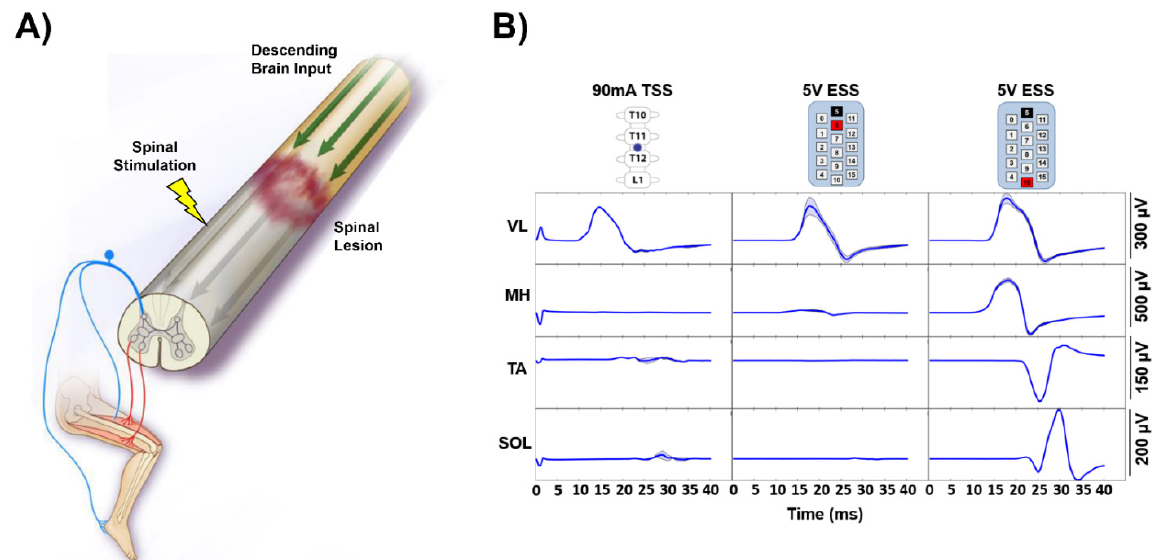
Figure 1. TSS- and ESS-Evoked Responses While Relaxed. A . A diagram depicting inputs and outputs to the spinal cord during spinal stimulation. Descending brain input (green arrows) is interrupted by the spinal cord lesion. Spinal stimulation (yellow lightning bolt) is hypothesized to function by activating the dorsal roots carrying afferent proprioceptive information to the spinal cord. Afferent proprioceptive inputs (blue) enter the spinal cord and efferent motor outputs (red) exit the spinal cord and returns to the muscle. This figure is adapted with permission from a previous publication [6]. B. While a study participant was instructed to relax while lying supine, stimulation was delivered to the same region of the spinal cord via transcutaneous spinal stimulation (TSS) and epidural spinal stimulation (ESS) using a focal and wide field. The dark line represents the average of at least three stimuli, and the shaded region indicates the ± standard deviation. VL— vastus lateralis, MH—medial hamstrings, TA—tibialis anterior, SOL—soleus, µV—microvolt, V—Volt, and mA—milliamp.